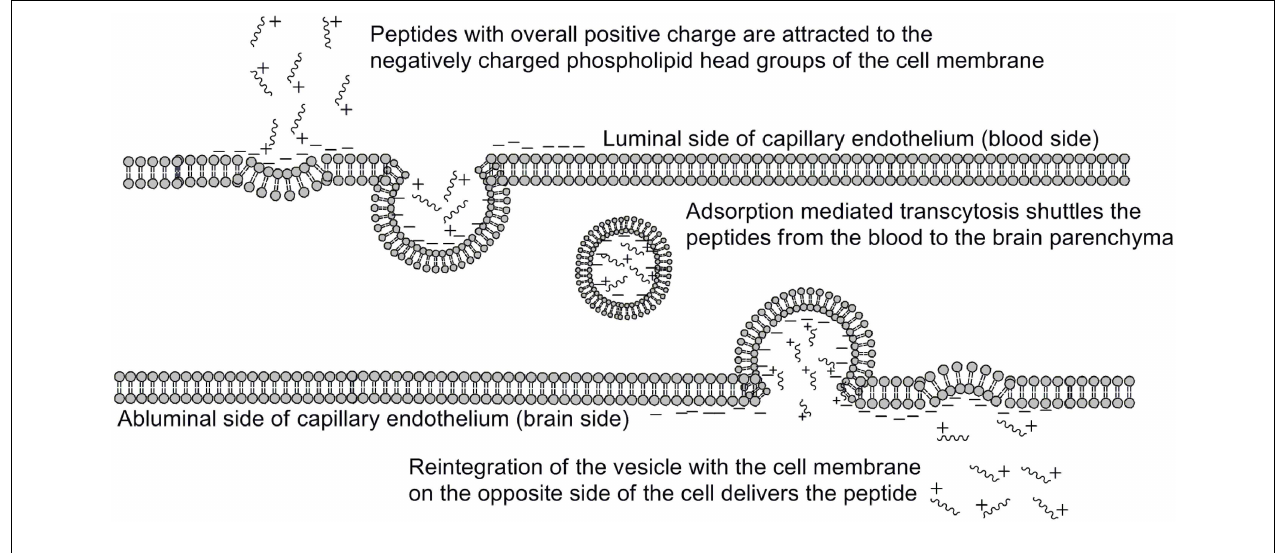
FIGURE 1 | Adsorptive mediated transcytosis as pathway for BBB penetration. Positively charged peptides in the bloodstream (1) associate with the negatively charged membrane surface, thereby inducing membrane invagination and vesicle formation. The